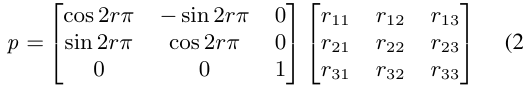
Figure 1. Normalised distribution of classes of datasets before and after weighted augmentation and non-uniform sampling for a) ScanNet and b) Semantic3D. A more horizontal line